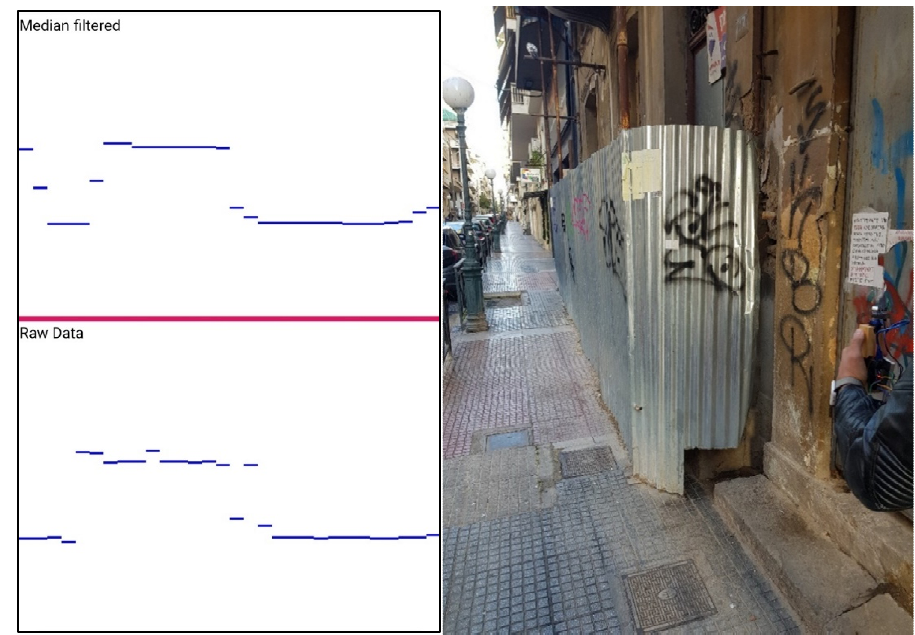
Figure 20. Response of sonar obstacle detection system.